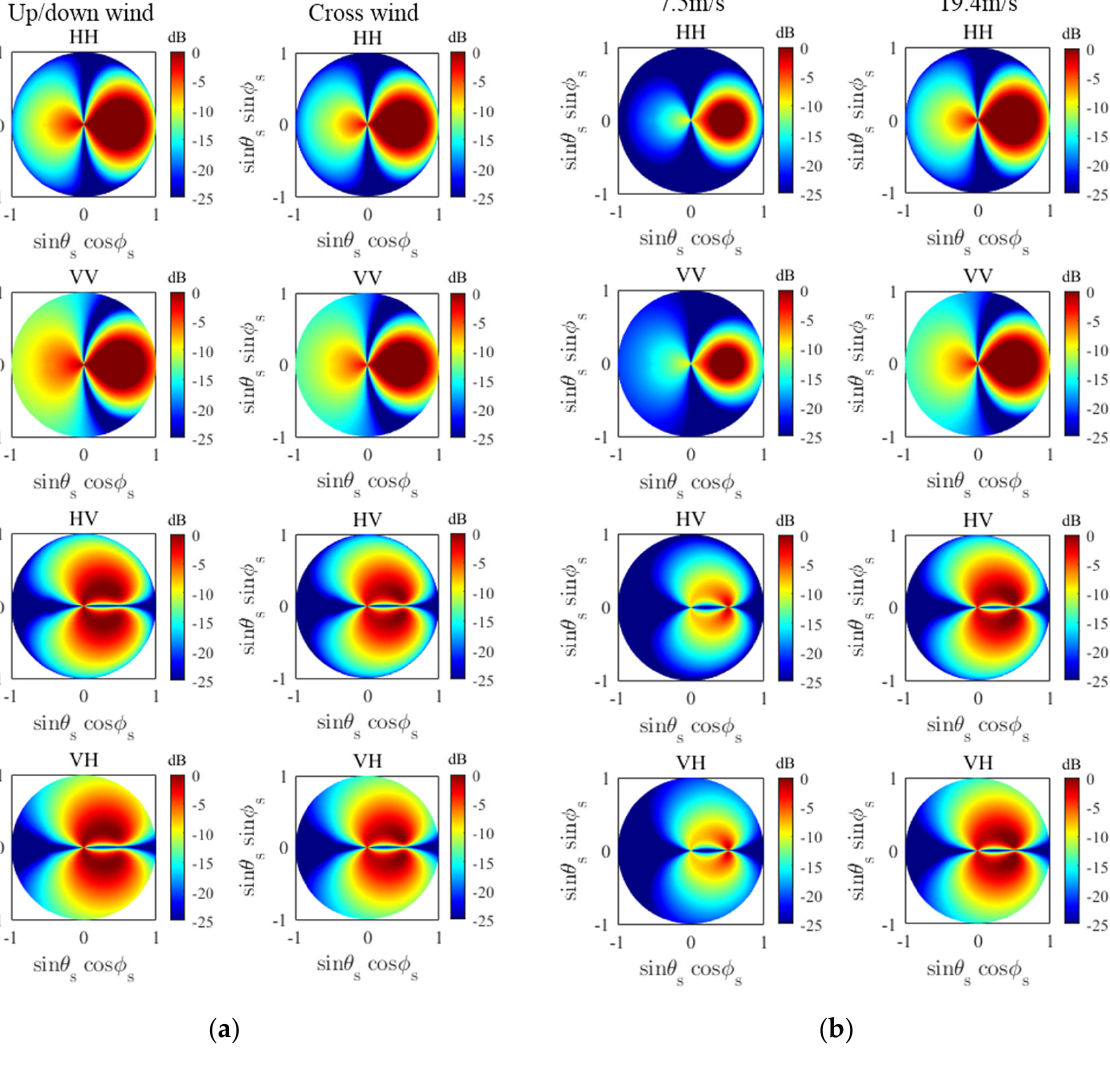
Figure 3. Hemispherical plots of bistatic scattering coefficients σ 0 , , , with , : ( a ) at 5.3 operating frequency, U = 25 m/s; wind direction for subplots in the left and right columns is up/downwind (0 ◦ /180 ◦ ) and crosswind (90 o ), respectively ( b ) at 13.9 GHz, φ w = 30 ◦ and U = 7.5 m/s for left-row subplots.